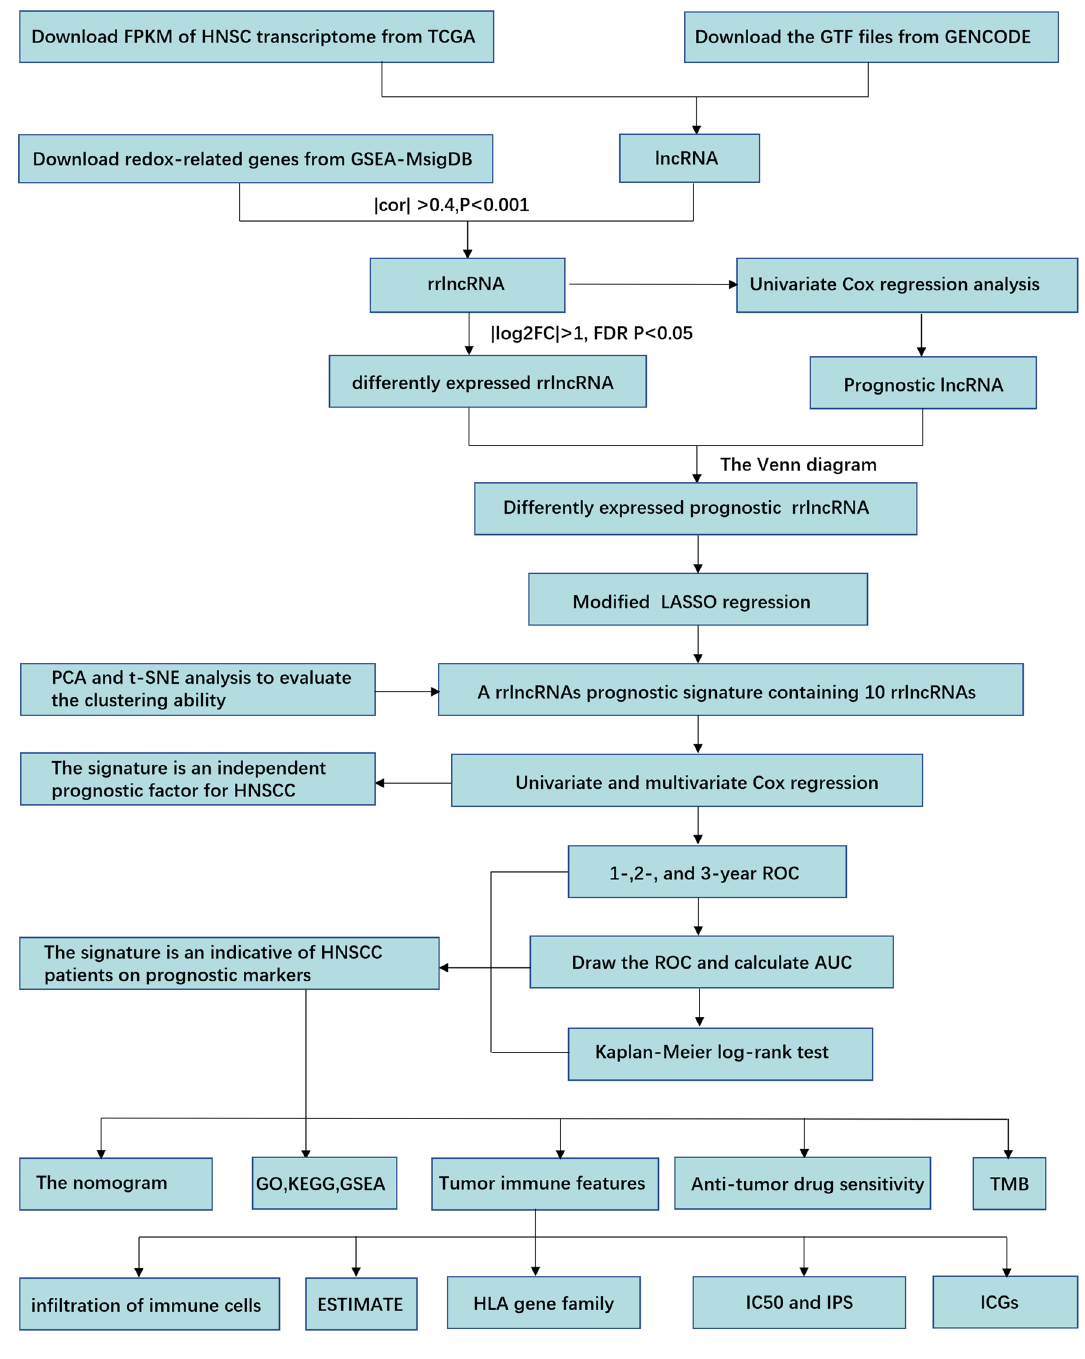
Figure 1. The flowchart of the present